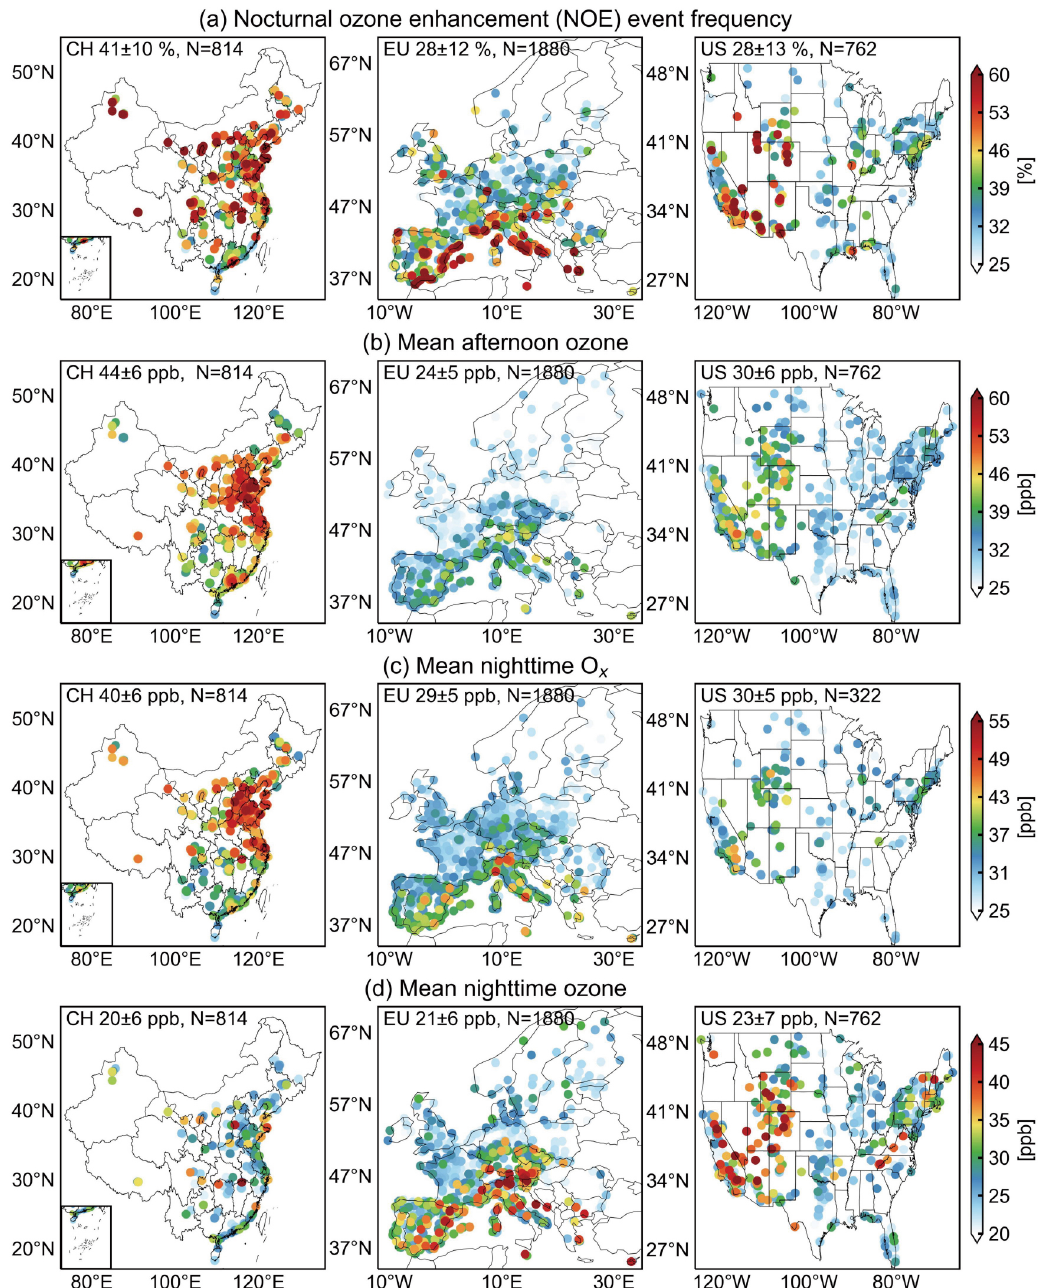
Figure 1. Comparison of the annual frequency of nocturnal ozone enhancement (NOE) events, mean afternoon (14:00–17:00LT) ozone, and mean nighttime (20:00–06:00LT) ozone between China (CH), Europe (EU), and the United States (US), averaged over 2014–2019. Only sites with continuous measurements are included. The regional mean values and standard deviations among the N sites are shown inset at the top of each figure (mean ± standard